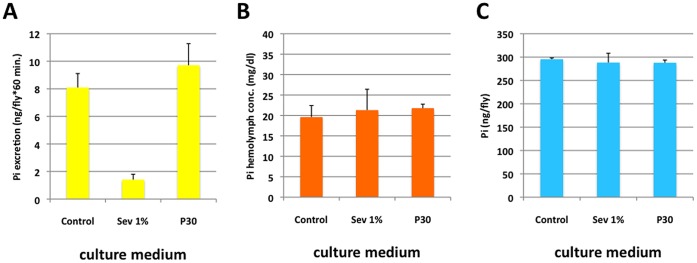
Adult hemolymph phosphate, phosphate excretion and whole fly Pi. A:Excretion of phosphate after culture of y w females for five days on standard medium (C) alone or supplemented with 1% sevelamer (Sev1%) and 30 mM sodium phosphate (P30) (n = 3 pooled collections of 15–20 flies). B: hemolymph phosphate concentration (n = 3 pooled collections of 15 flies) and C: whole fly phosphate (n = 10) of flies cultured as described for A. Note that y w and CS flies have lower hemolymph phosphate concentrations than OR and w1118 flies and the F1 generation females that express control RNAis (see Methods and Fig. S5), which is likely due to differences in genetic background.